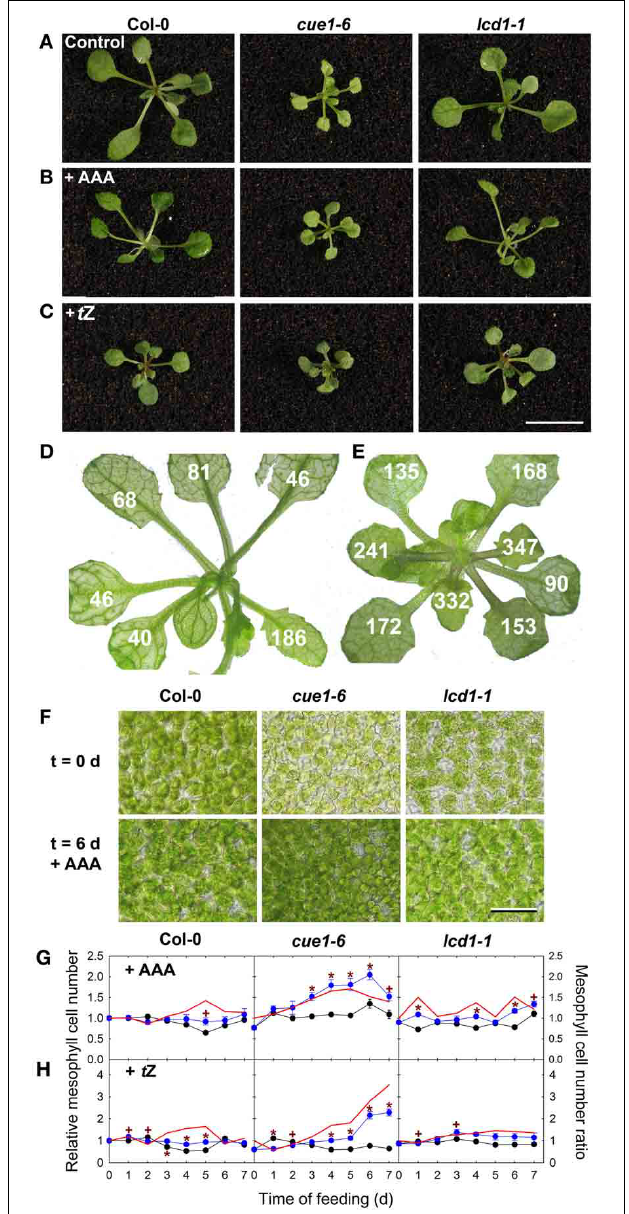
FIGURE 6 | Effect of AAA and t Z on mesophyll cell density in cue1 and lcd1 leaves. Plants were grown for six days on ½MS-agar supplemented with 2mM each of AAA (B) or 1 μ M t Z (C) compared to an unfed control (A) . Examples of mesophyll cell density numbers (cells per 0.05mm 2 ) counted in individual leaves of cue1-6 grown on 1 μ M t Z (E) compared to an unfed control of cue1-6 (D) . Mesophyll cell density of Col-0, cue1-6 and lcd1-1 six days after feeding a cocktail of AAA compared to an unfed control (F) . Each microscopic picture represents an area of 0.05mm 2 with a bar indicating a length of 100 μ m. Time course of relative mesophyll cell numbers in leaves of Col-0, cue1-6 , and lcd1-1 after feeding of AAA (G) or t Z (H) . The blue or black symbols represent relative mesophyll cell numbers in the presence or absence of the effectors (AAA or t Z), and the red line represents the ratio of mesophyll cell numbers ± effector. The initial cell density was about 100, 60, or 86 cells per 0.05mm 2 in leaves of Col-0, cue1-6 , or lcd1-1 , respectively. The bar in (C) represents a length of 1cm. The data in (G) and (H) represent the mean ± SE of n = 10 measurements per time point and